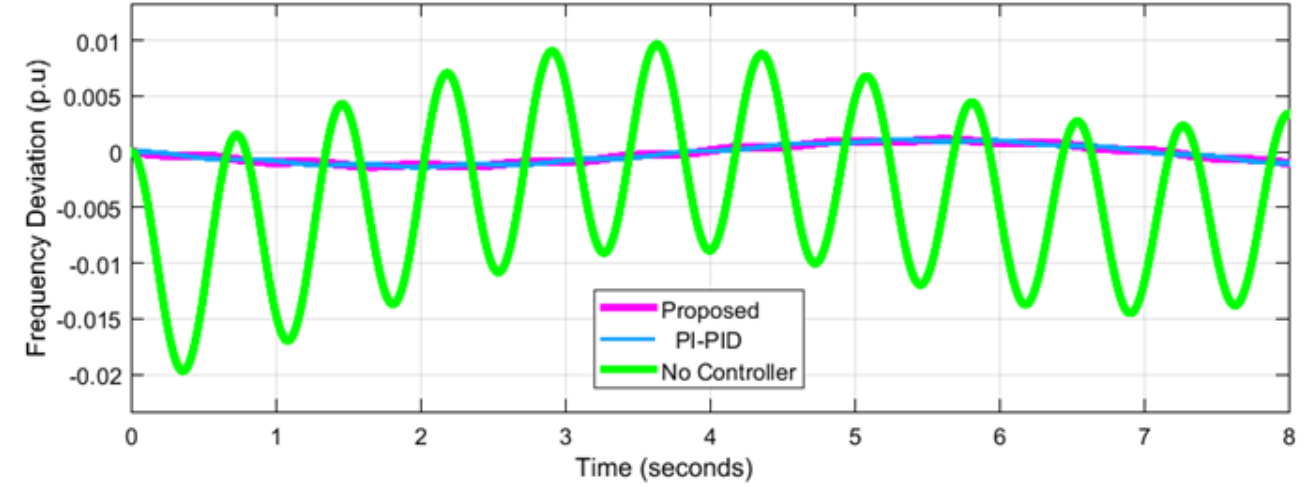
Figure 5. Case 2: frequency deviation at (K p = −1.9600, K i = −0.0024) for network 1.